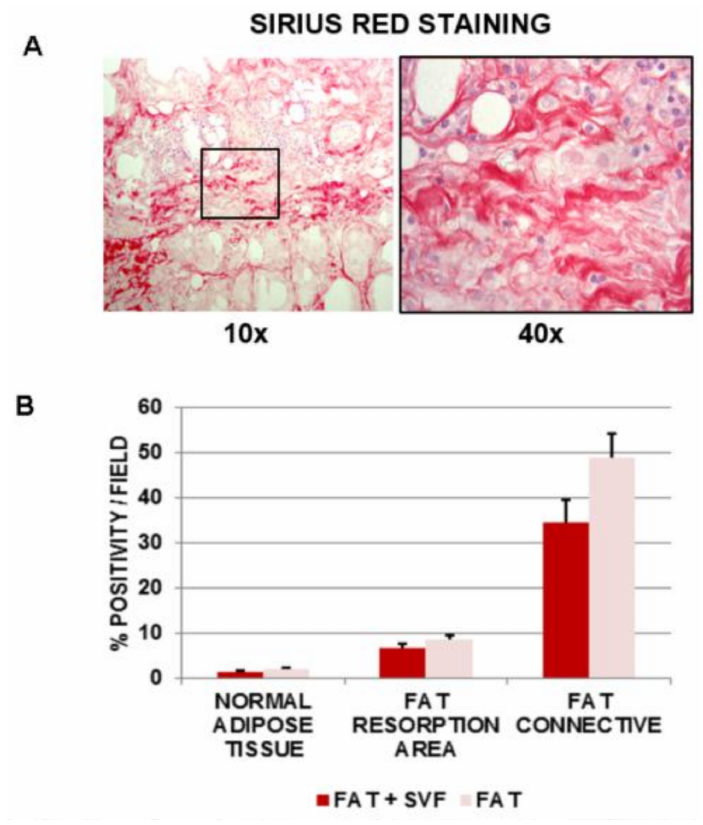
Figure 5. ( A ) Sirius red staining image to evaluate the grade of fibrosis in the FAT and FAT + SVF samples. 100 × magnification (left) and 400 × (right). ( B ) Sirius red quantification was performed for each of the distinct fat features/areas in the two